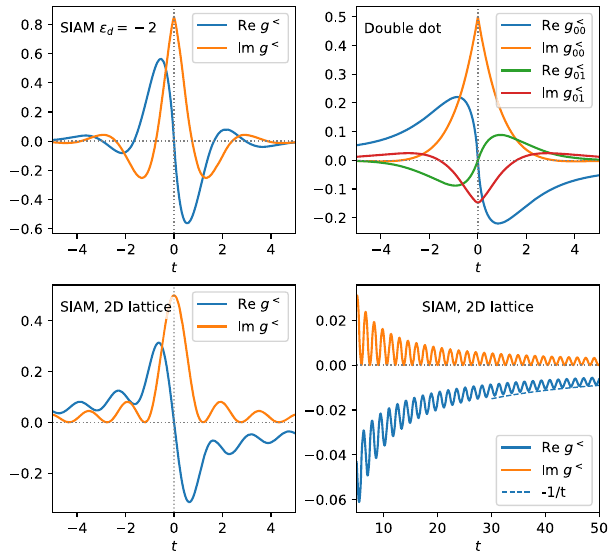
FIG. 6. Real-time noninteracting lesser Green ’ s functions for the three models considered in this paper. Upper panel: single quantum dot (SIAM) and double quantum dot connected to leads in the flat-band limit. Lower panel: one interacting site in the 2D lattice, including the tail of g < ð t Þ